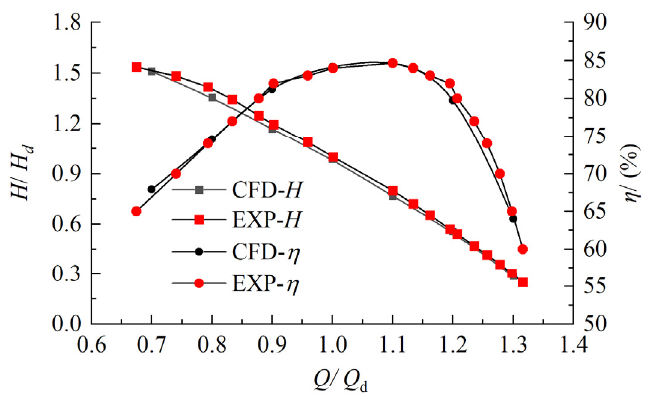
Figure 4. Comparison of the CFD results and the experiment results on hydraulic performance.